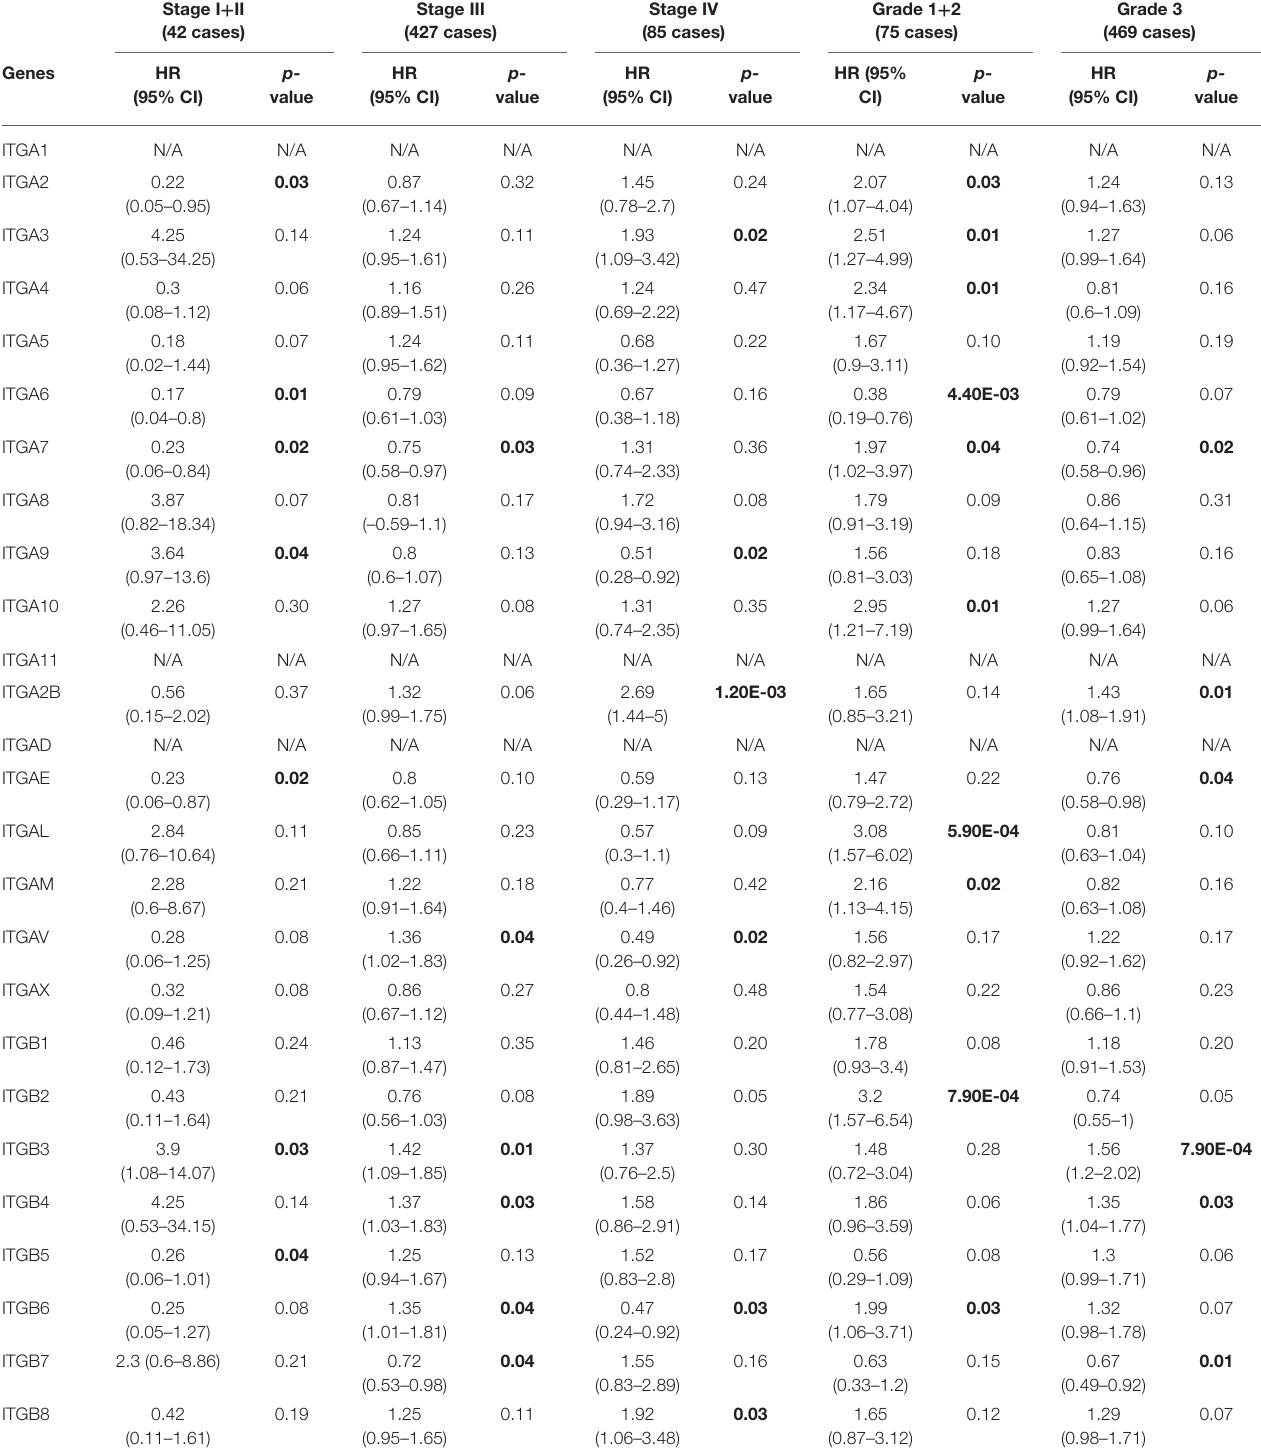
TABLE 2 | The relationship between integrins and OS in different tumor grades and stages of OC (Kaplan–Meier plotter). Stage I + II (42